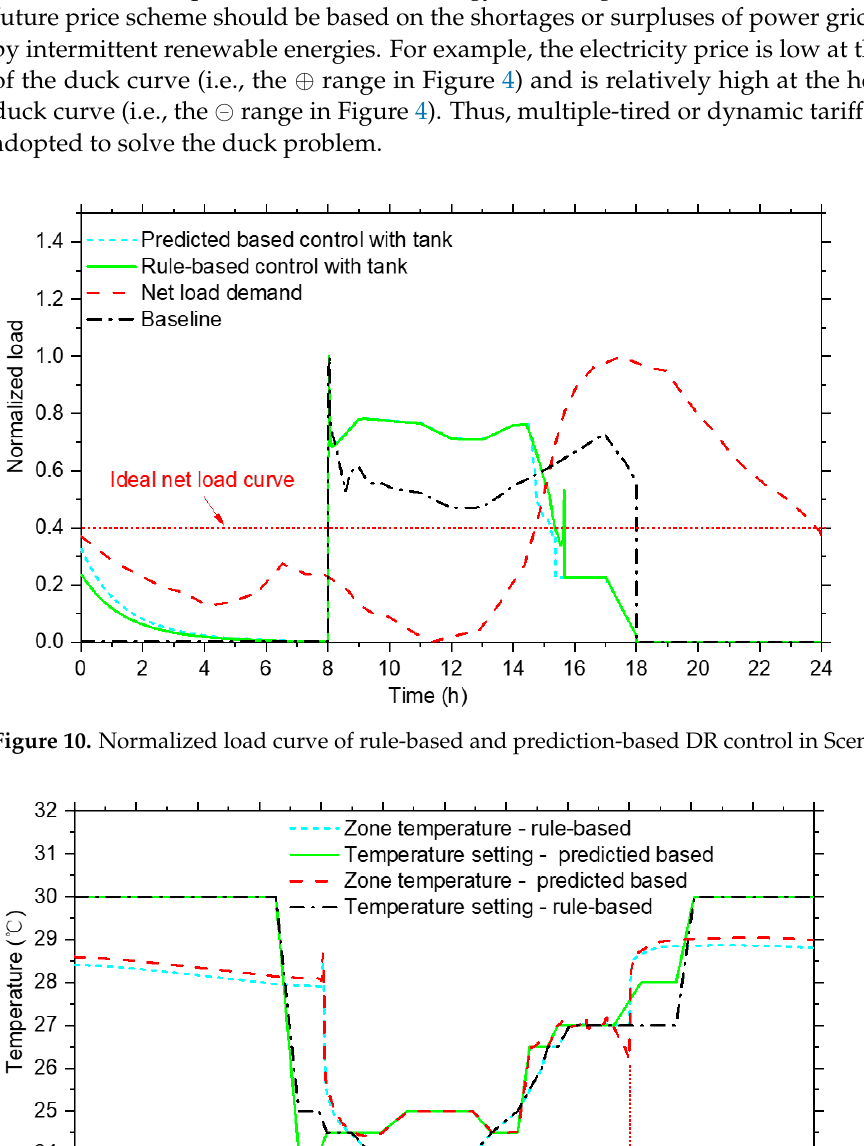
Figure 9. Normalized load curve of rule-based and prediction-based demand response (DR) control in Scenario 1.